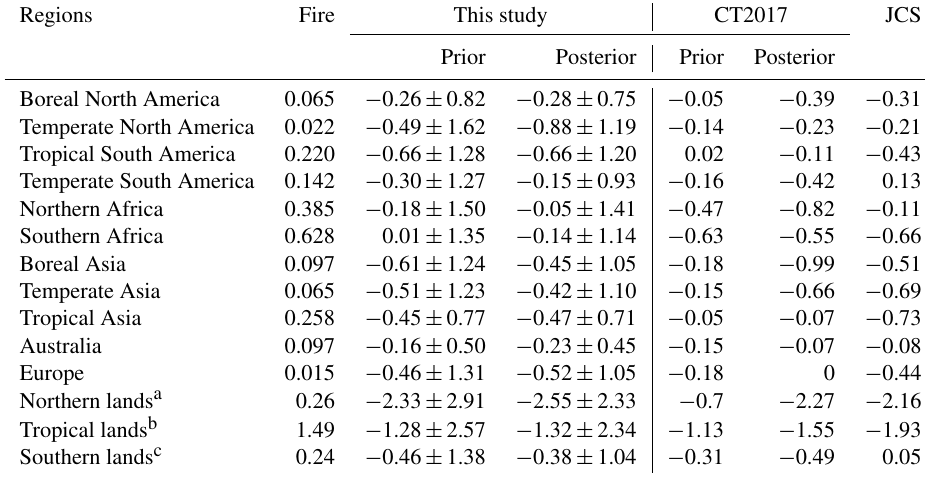
Table 4. Regional BIO and FIRE flux in the 11 TransCom land regions (PgCyr − 1 ). Regions Fire This study